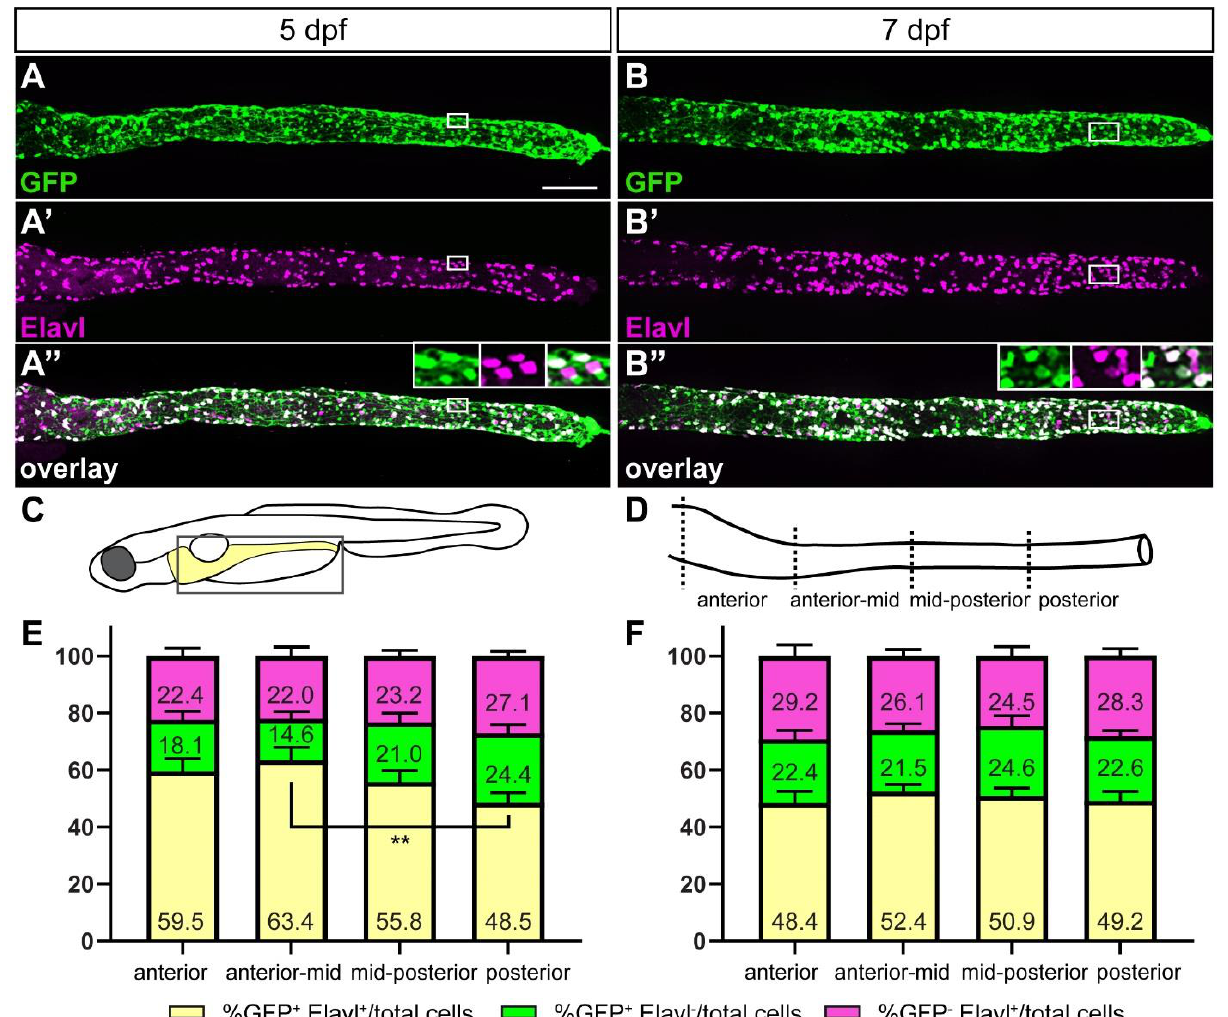
Figure 3. The majority of GFP + cells are ENS neurons at later stages of ENS development. At 5 ( A – A’’ ) and 7 ( B – B’’ ) days post fertilization (dpf) GFP + ENS neurons (white) are found along the whole length of the gut. A smaller fraction are GFP + non-neuronal cells (green) or GFP − ENS neurons (magenta). Insets in ( A’’ , B’’ ) show the close-up of the boxed area, GFP, Elavl, and overlay from left to right. Schematic of boxed area of larval schematic ( C ) indicates the four gut sub-regions analyzed ( D ). Quantification of GFP and Elavl colocalization at 5 dpf ( E ) and 7 dpf ( F ) in four gut regions shown in ( D ). Bar graph shows % GFP + /Elavl + out of total number of cells quantified [GFP + /Elavl + , GFP + /Elavl − , and GFP − /Elavl + ], (yellow), % GFP + /Elavl − out of total cells (green), and % GFP − /Elavl + out of total cells (magenta). Using 2-way ANOVA, we did not find significant differences between the cell populations of the different gut regions except where indicated (** p ≤ 0.01) . Error bars show ± standard error of the mean (5 dpf: 2 experiments, 19 larvae; 7 dpf: 2 experiments, 15 larvae). ( A – A’’ , B – B’’ ): maximum projections of dissected guts at stage indicated. Scale bar = 100 µm.